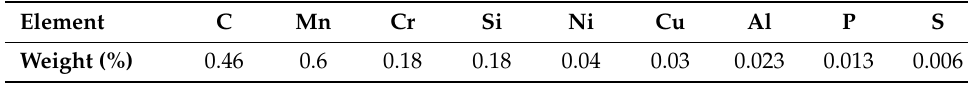
Table 1. The chemical composition of the carbon steel (C-steel). Element